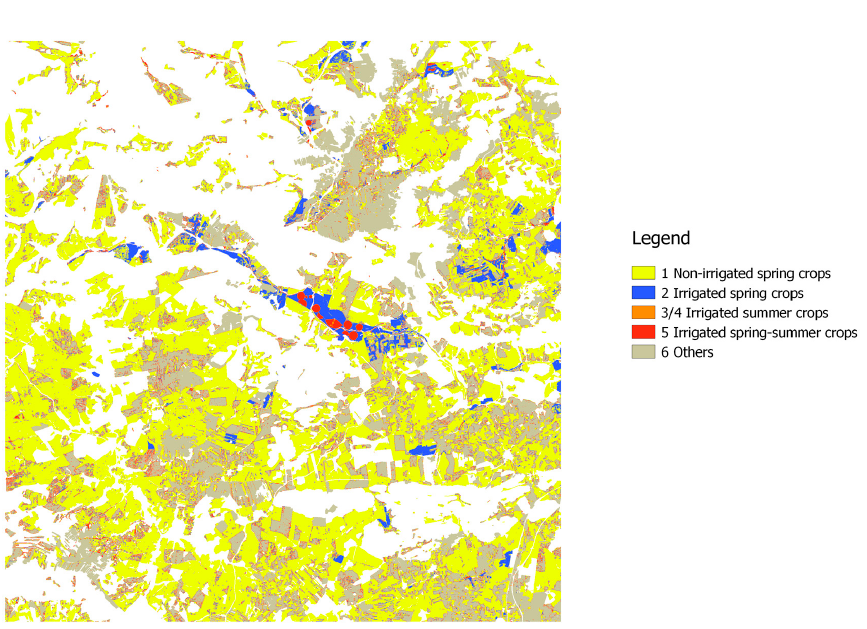
Figure 8. TS2 Irrigation map.